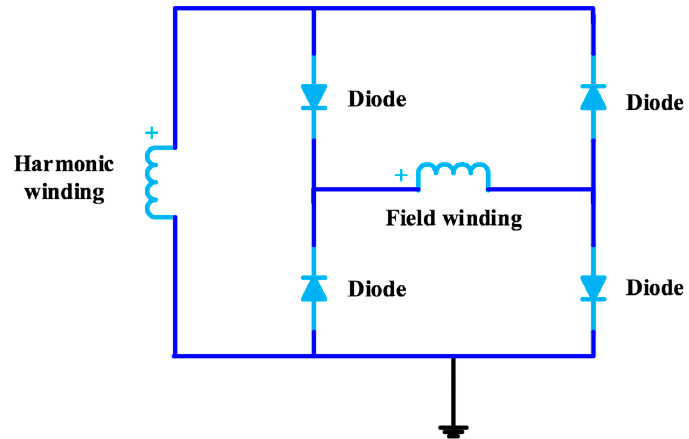
Energies 2020 , 12 , x FOR PEER REVIEW Figure 7. Rotor circuit showing the connection of harmonic and field windings. Figure 7. Rotor circuit showing the connection of harmonic and field windings.